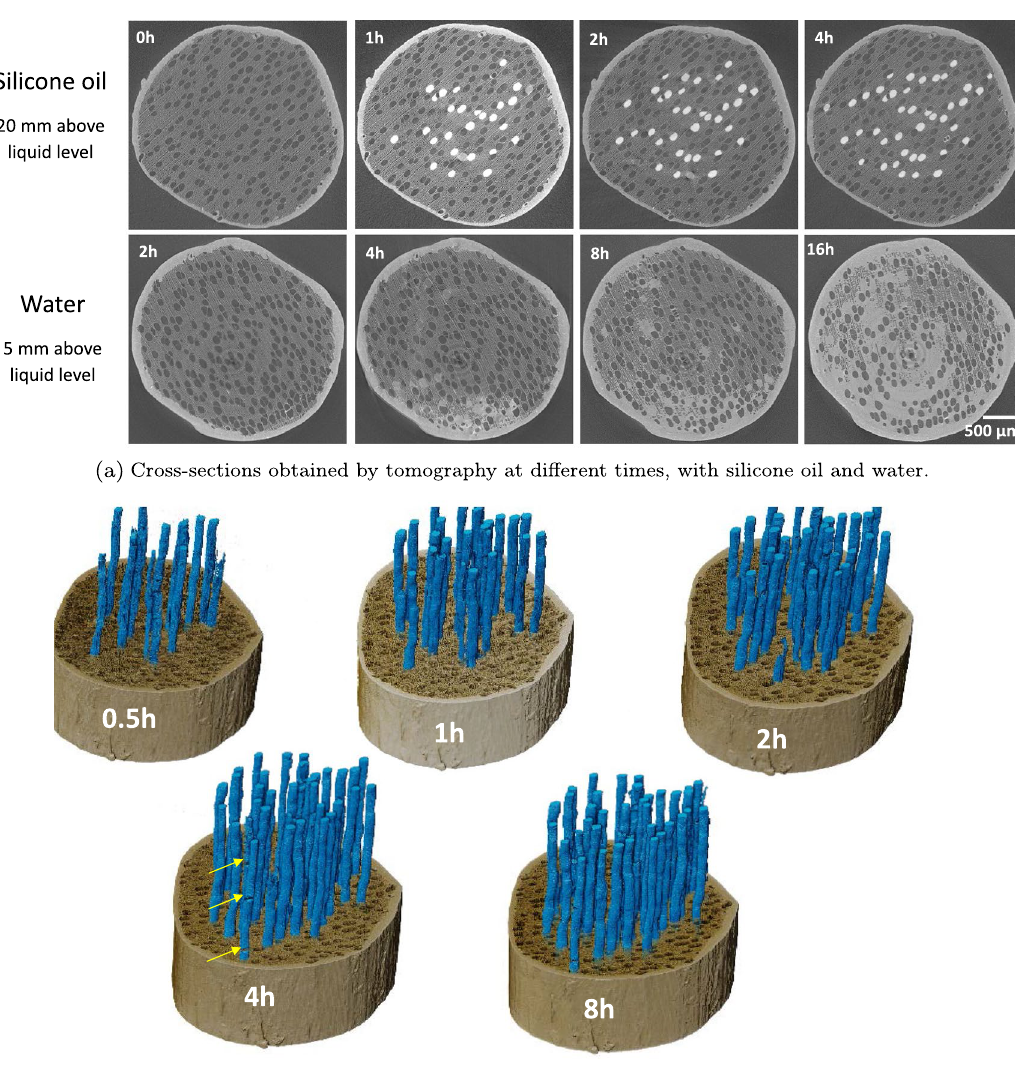
Figure 3. Dynamics of liquid imbibition in poplar: cross sections and 3D reconstruction at different